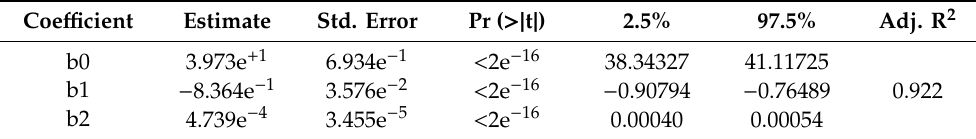
Table 11. Results of the regression analysis and coe ffi cient estimation – flexural strength (fb =